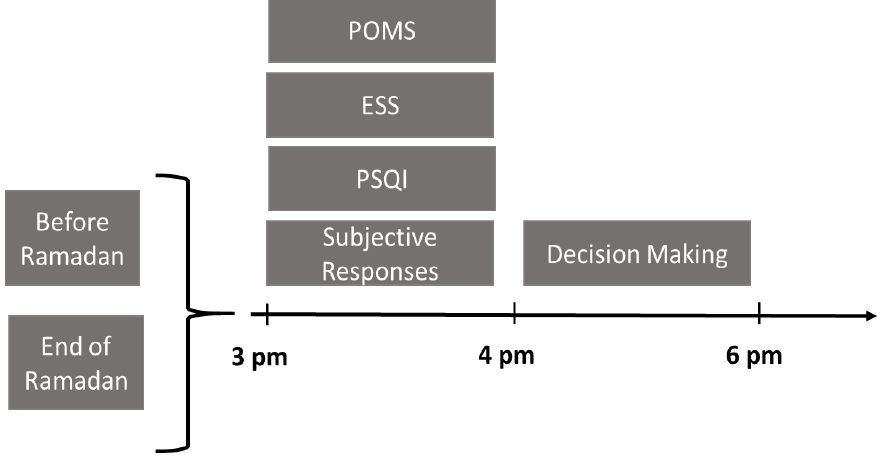
Figure 1. The schematic representation of the experimental